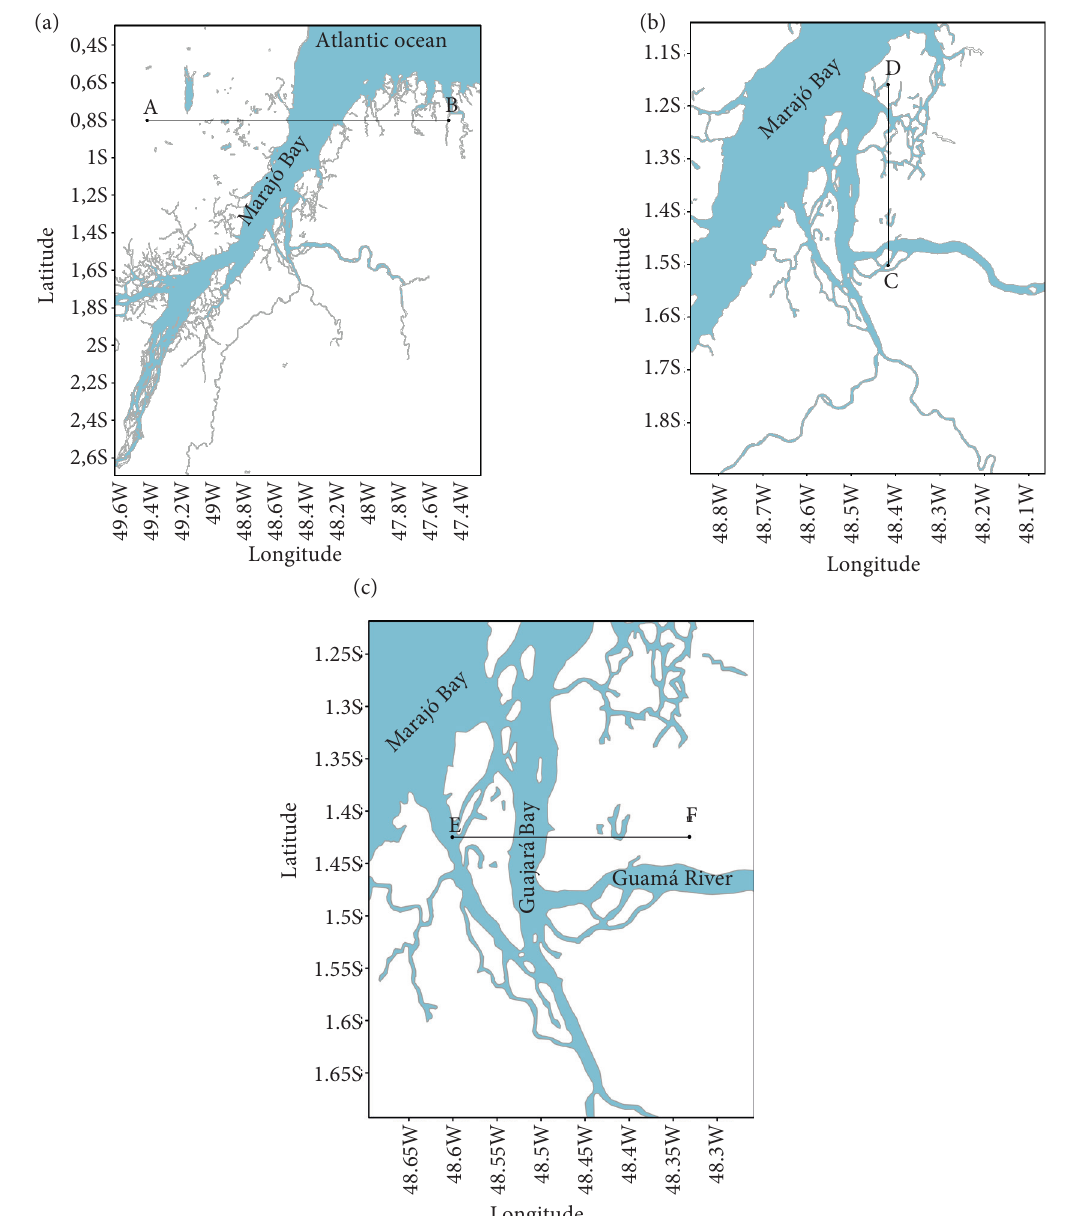
Figure 3. Transects analyzed in the simulations: AB (a), CD (b), and EF